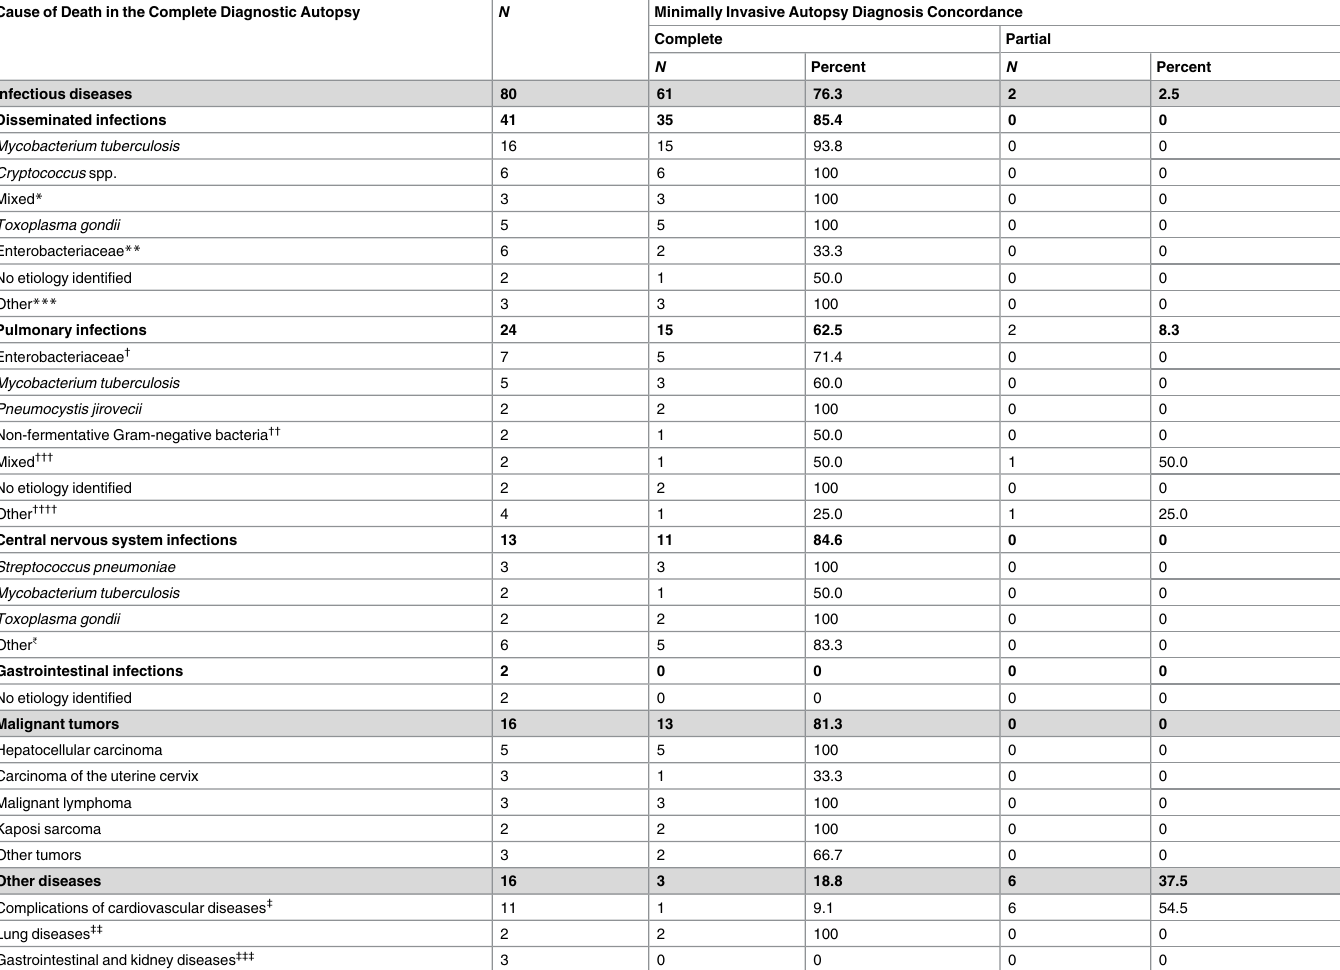
Table 3. Causes of death determined by the complete diagnostic autopsy and concordance of the minimally invasive autopsy diagnosis with the complete diagnostic autopsy diagnosis. CauseofDeathintheCompleteDiagnosticAutopsy N